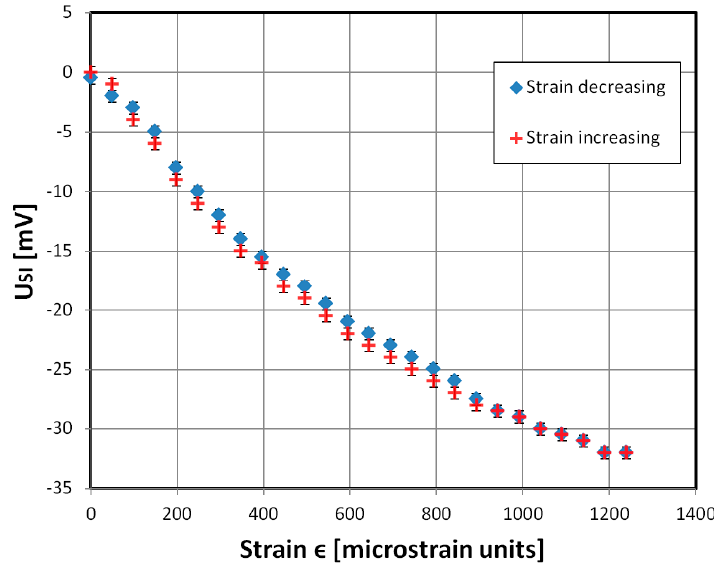
Figure 5. Dependence of measured ∆ U min , the minimum of the voltage drop signal, under full strain, on the driving current frequency. Materials 2018 , 11 , x FOR PEER REVIEW